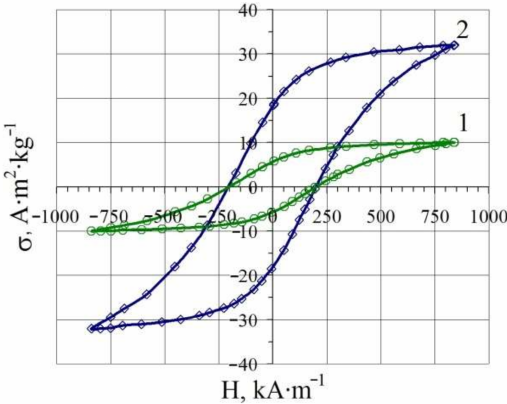
Figure 11. Curves of magnetization of SmCo 5 /HEMA-gr-PVP composites with different content of SmCo 5 (Composition formulation, mass parts: HEMA:PVP = 70:30): 1—20 wt.%.; 2—80